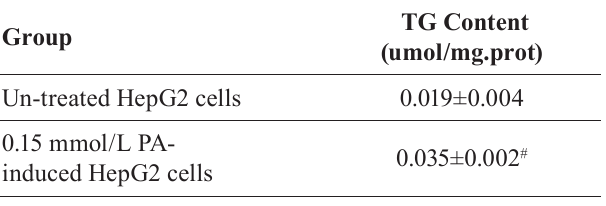
TABLE I - I ntracellular TG content of HepG2 cells after 24 h induction with PA (n=4, ±s)